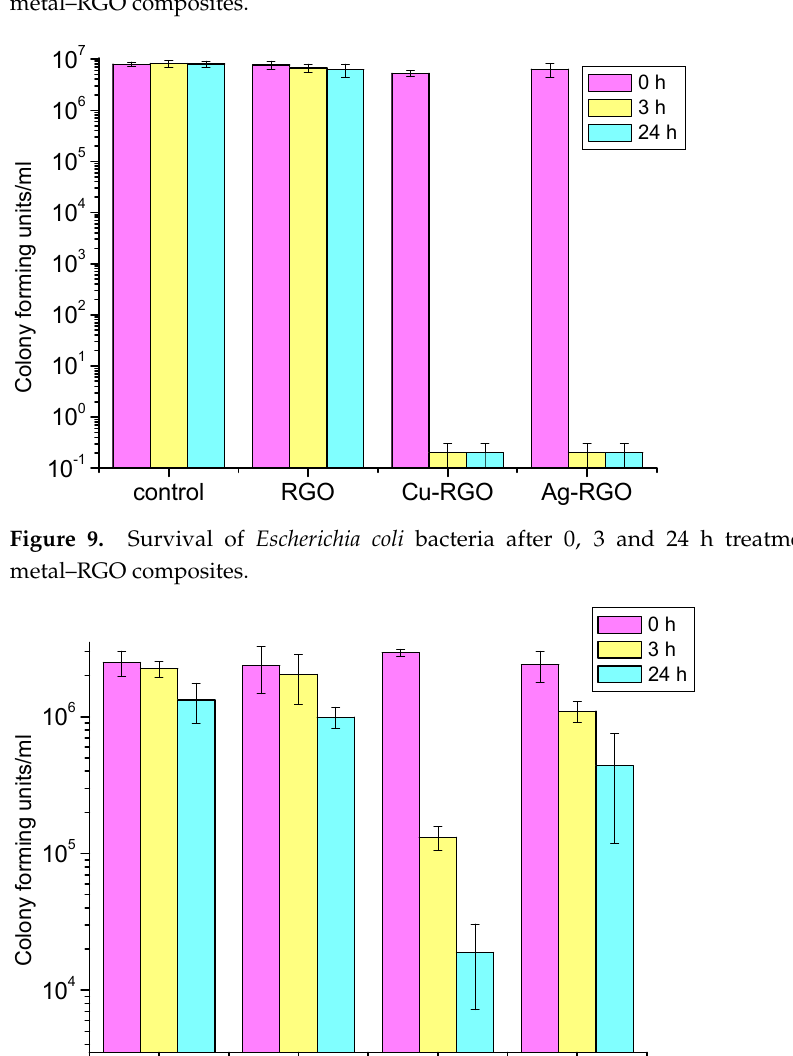
Figure 10. Survival of Candida albicans fungi after 0, 3 and 24 h treatment with RGO and metal–RGO composites.